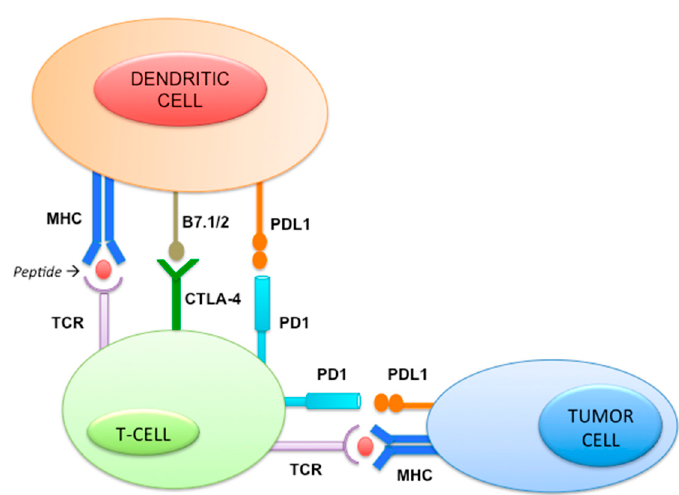
Figure 5. Immune pathway and the immune-checkpoints. TCR: T cell receptor, CTLA4: T-lymphocyte-associated antigen 4, B7.1: Cluster of differentiation 80, B7.2: Cluster of differentiation 86, MHC: Major histocompatibility complex, PD1: programmed cell death protein 1, PDL: PD1 ligand.